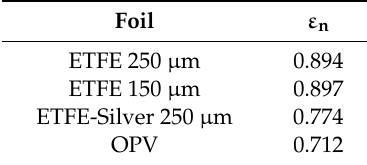
Table 3. Summary of normal emissivity.